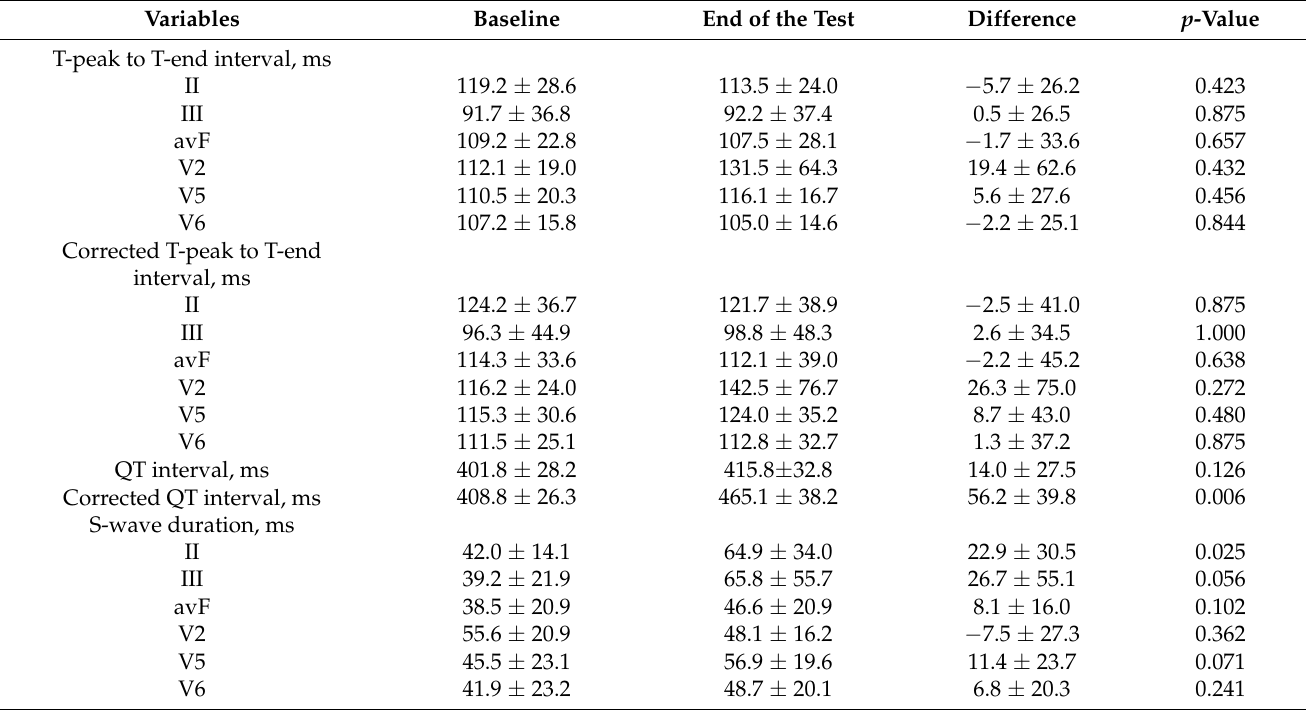
Table 4. Electrocardiographic changes after ajmaline infusion in diagnosed Brugada syndrome